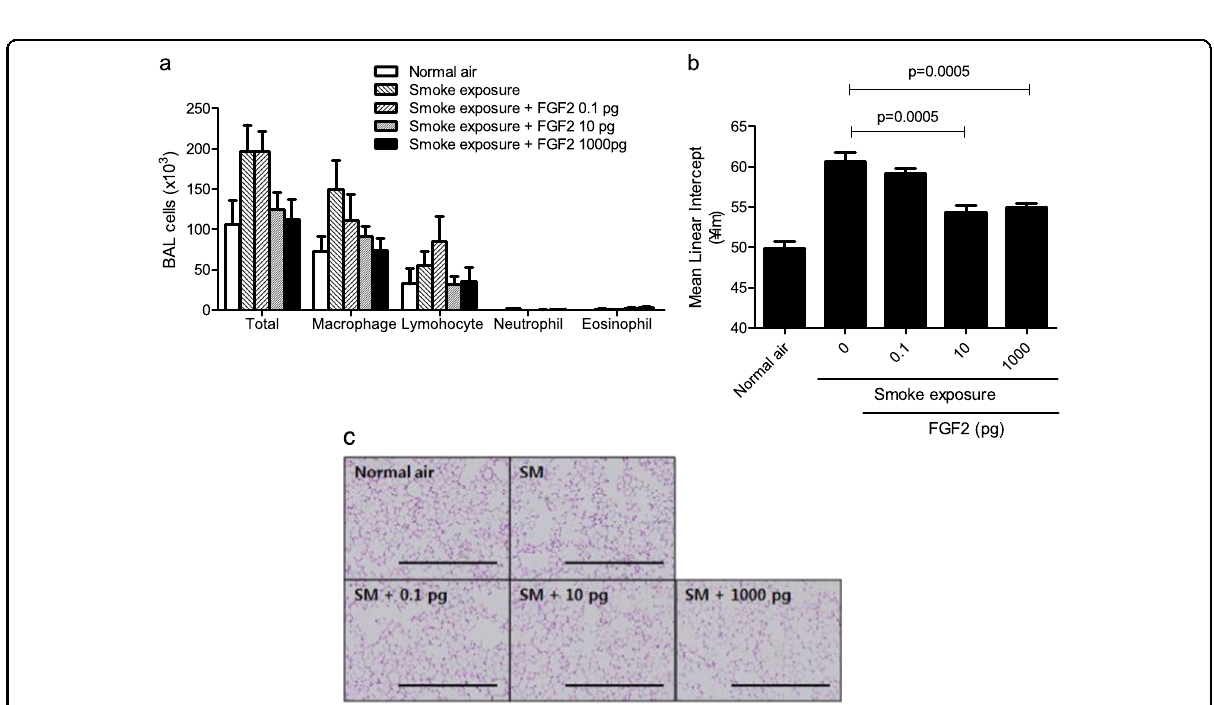
Fig. 3 Protective effects of FGF-2 on early emphysema in response to short-term exposure to cigarette smoke. a – c The mice were exposed to cigarette smoke for 4 days, and 0.1, 10, and 1000 pg of FGF-2 was administered intranasally within 1 h after smoke exposure. Mice were killed 18 h after the fi nal smoke exposure. a Cellularity in BAL fl uid. P -values were determined by two-way analysis of variance. b MLI ( n = 6 – 12 per group). P - values were determined by the Mann – Whitney test. c Lung histology with hematoxylin and eosin (H&E) staining (scale bar = 1